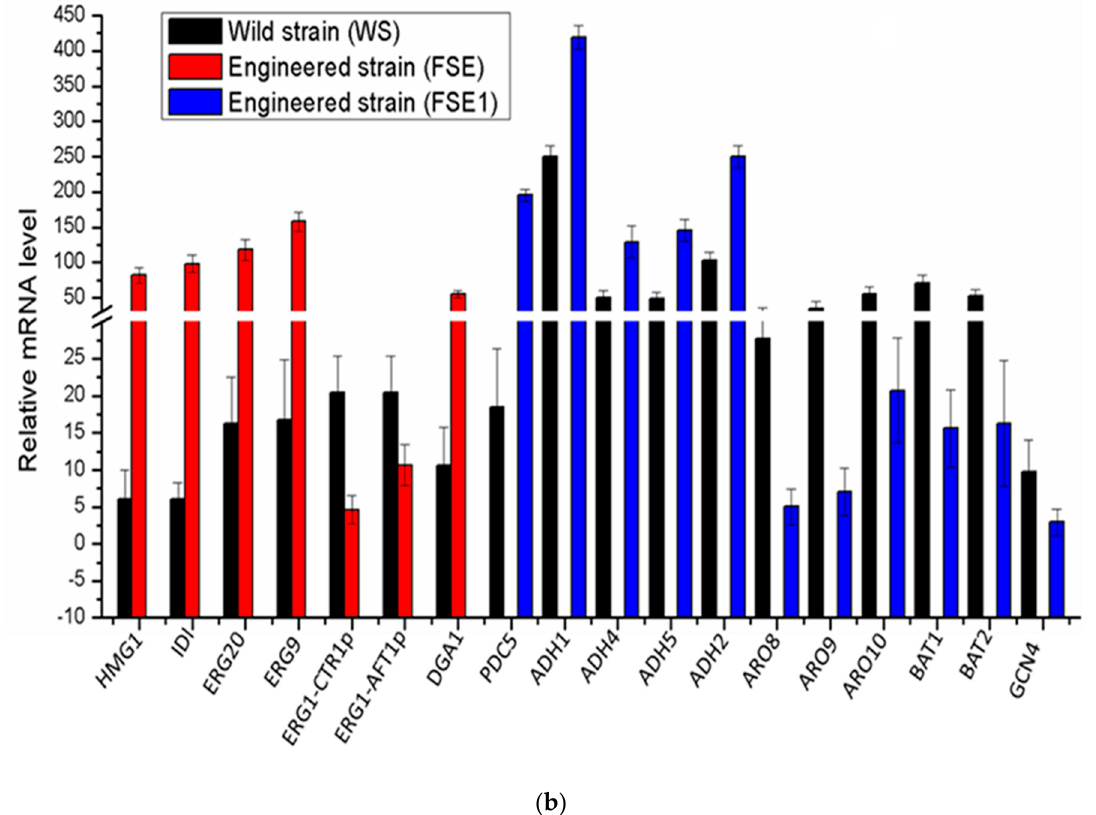
Figure 3. (a) Module-1 consists of HMG1, IDI1, ERG20 and ERG9 genes of squalene biosynthesis pathway, was transformed into Saccharomyces cerevisiae leading to the FSE strain and module-2 comprises of PDC5, ADH1, ADH4, ADH5 and ADH2 genes of ethanol production pathway was transformed into FSE strain leading to the FSE strain. Engineered promoters TFBS TEF -HHF2p, TFBS TEF -IRA1p, TFBS TEF -RHO1p, TFBS TEF -PET9p, and TFBS HHF2 -HHF2p, TFBS HHF2 -IRA1p, TFBS HHF2 -RHO1p, TFBS HHF2 -PET9p were employed to overexpress the genes of squalene and ethanol production pathways, respectively. Names of the terminators are given in Table S2 with their primers. (b) qRT-PCR analysis of (i) overexpressed genes of SB and EP pathways, (ii) ERG1 under repressible promoters, (iii) genes of fusel alcohol pathway: The expression level of HMG1 , IDI1 , ERG20 and ERG9 genes of squalene biosynthesis pathway was enhanced in FSE strain compared to the WS after employing TFBS TEF1- HHF2p, TFBS TEF1- IRA1p, TFBS TEF1- RHO1p, and TFBS TEF1- PET9p promoters, respectively. The expression level of the ERG1 gene was decreased in FSE strain compared to the WS after employing AFT1p and CTR1p repressible promoters. The expression level of PDC5, ADH1 , ADH4 , ADH5, and ADH2 genes was enhanced in FSE1 strain compared to the WS after employing the TFBS HHF2- HHF2p, TFBS HHF2- IRA1p, TFBS HHF2- RHO1p, and TFBS HHF2- PET9p promoters, respectively. Engineered promoters enhanced the expression of target genes of each pathway, and metal ion repressible promoters downregulated the expression of ERG1 genes. The expression level of genes such as transcription factor regulator GCN4 and ARO8 , ARO9, ARO10, BAT1 , and BAT2 of fusel alcohol pathway in FSE1 strain compared to the wild type strain (WS) was downregulated. Error bars represent the standard deviation of biological triplicate.